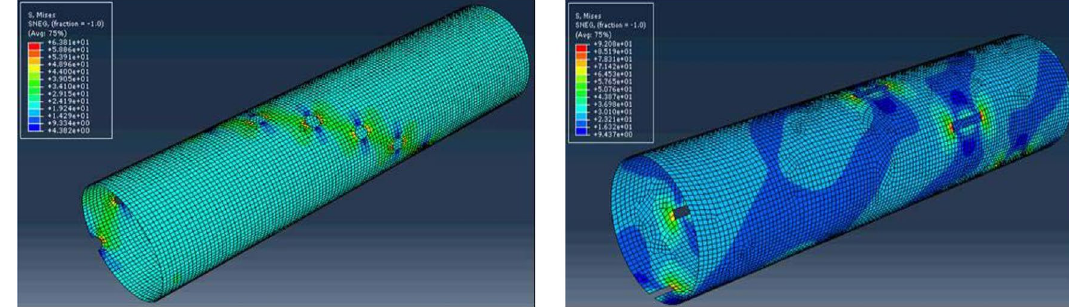
Fig. 4 Finite element analysis results of the collapse strength of slotted screen and perforated screen